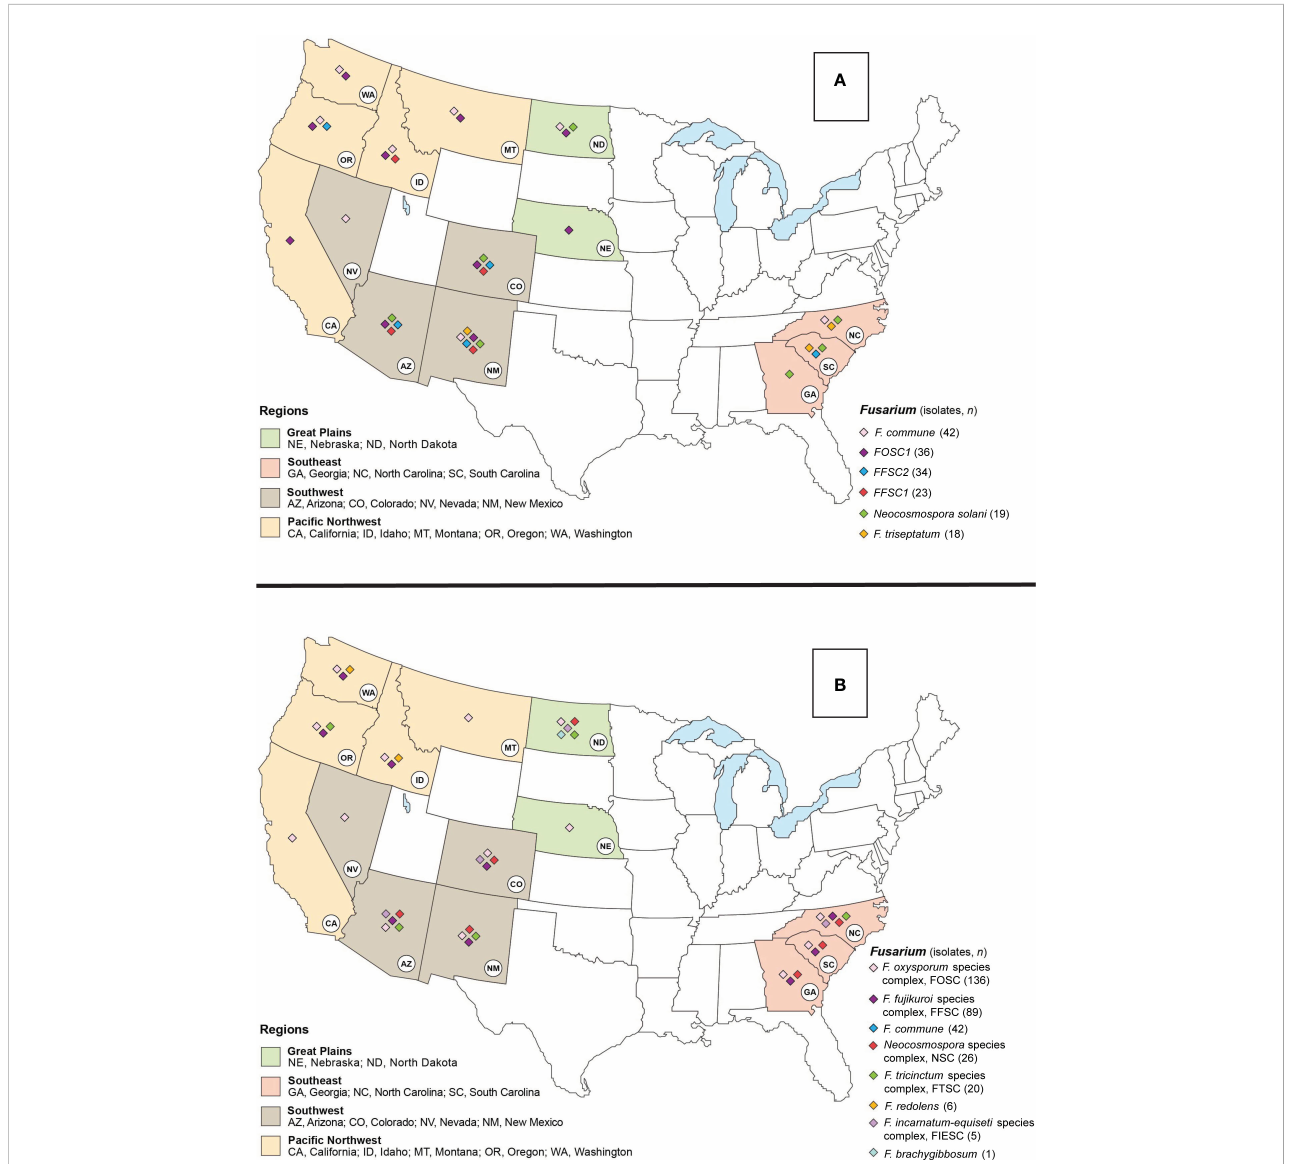
FIGURE 1 Map of the United States (USA) indicating the six most abundant Fusarioid fungi (A) and the Fusarioid species complexes (B) identi fi ed through a damping-off and root disease survey of conifer seedlings in states within the Southwest, Southeast, Paci fi c Northwest, and Great Plains regions. The colors on the states indicate their regional designation and the colored diamonds over the states indicates the presence of one of the six Fusarioid fungi identi fi ed in that